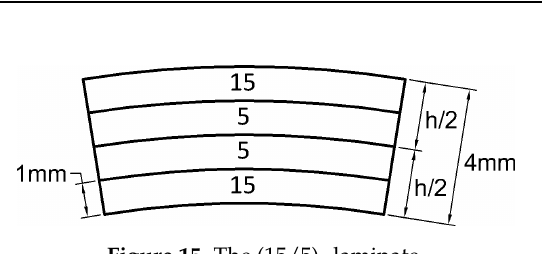
Figure 15. The (15/5) s